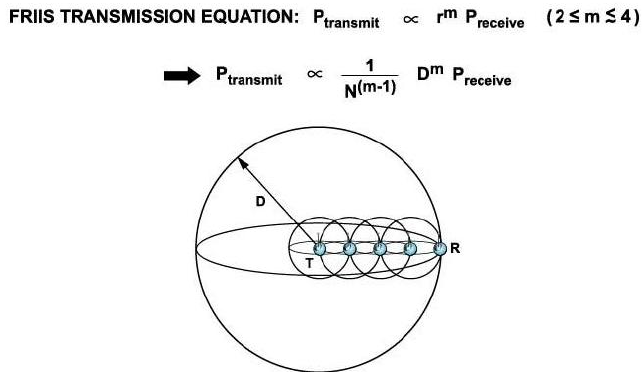
Figure 6. To communicate data from pod T to pod R, multi-hopping is more power efficient than simple direct transmission. The spheres represent where power is transmitted in the case of free